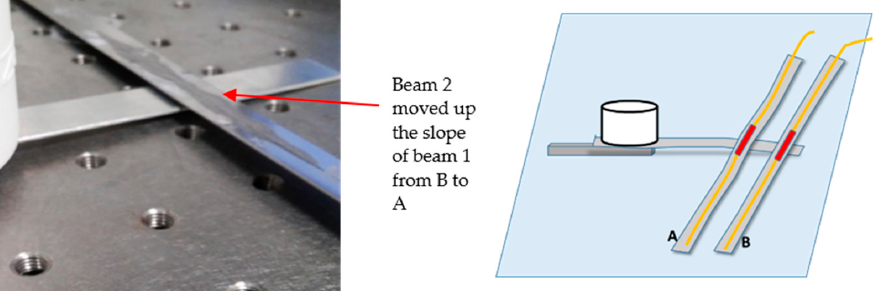
Figure 3. Experimental configuration with sensing beam moved closer to the acoustic source. The schematic shows positions A and B.